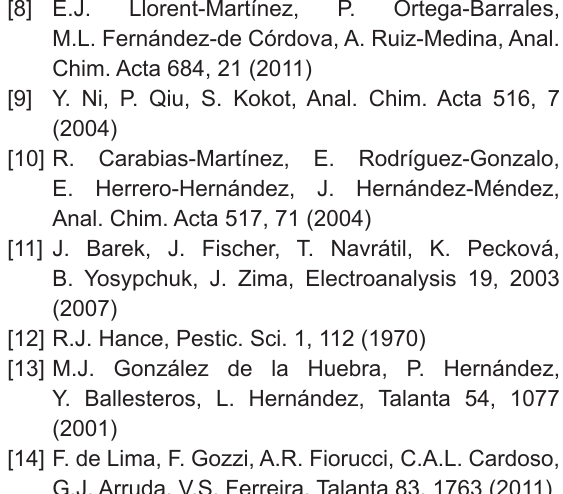
RSD: relative standard deviation (mean of three measurements) a The added amounts of linuron in the tap water were 0.009 and 0.036 μmol cm -3 μmol cm -3